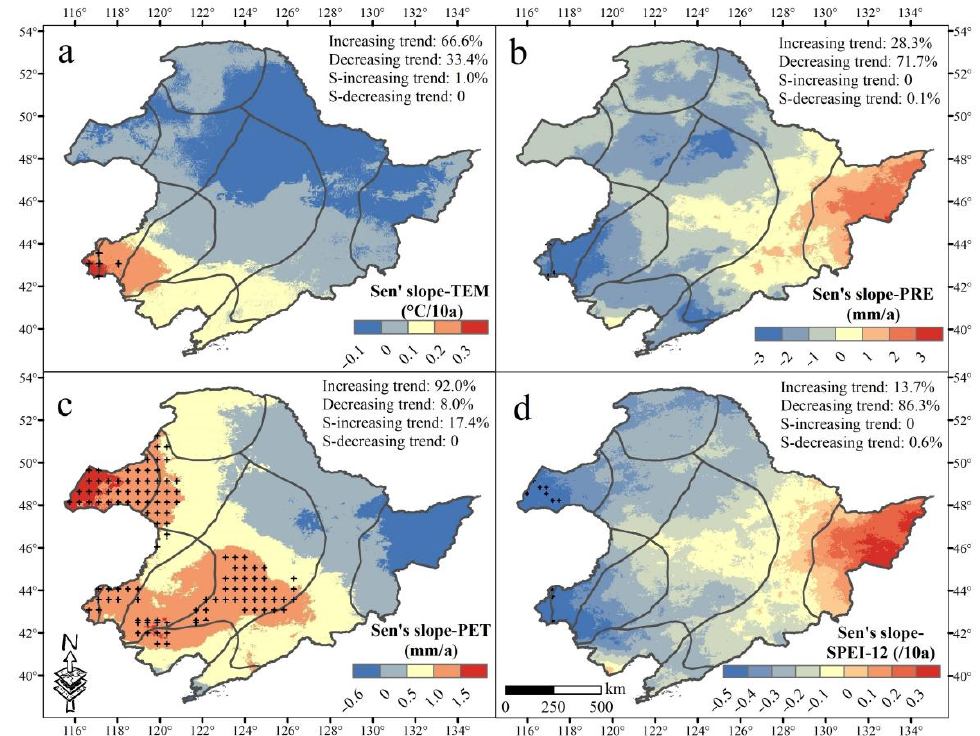
Figure 3. Spatial trends of mean annual temperature (TEM, ( a )), precipitation (PRE, ( b )), potential evapotranspiration (PET, ( c )), and SPEI-12 ( d ) in Northeast China (NEC) during 1990–2018. S- in the figure is the abbreviation for significant. Black crosses indicate significant trends with p < 0.05.